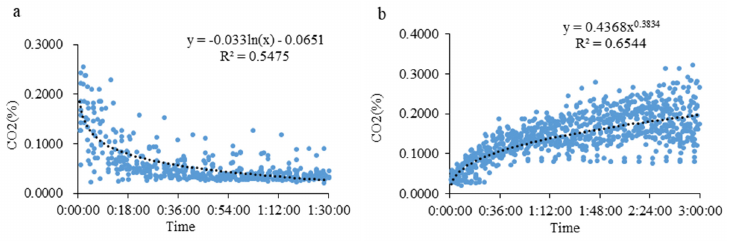
Figure 3. Mathematical model of CO 2 concentration change in the treatment group after the door was opened or closed. ( a ) 9:30–11:00 light-controlled goat house CO 2 concentration change model; ( b ) 16:30–19:30 light-controlled goat house CO 2 concentration change